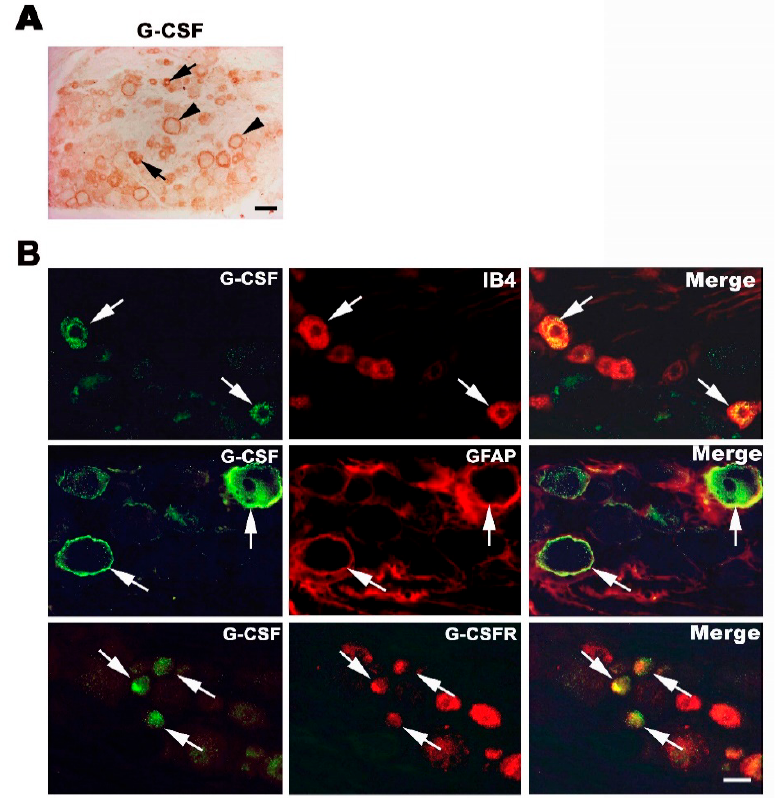
Figure 2. Expression of G-CSF in the DRG. ( A ) G-CSF immunohistochemistry. Note that G-CSF was expressed in small- and medium-diameter DRG neurons (arrow) and satellite cells around large-diameter DRG neurons (arrowhead). Bar = 50 μ m. ( B ) Characteristics of the cell types expressing G-CSF in the DRG. DRG sections were double immunostained with anti-G-CSF and IB4, anti-G-CSF and anti-GFAP or anti-G-CSF and anti-G-CSFR antibodies. Co-stained cells are indicated by arrows. Bar = 30 μ m.